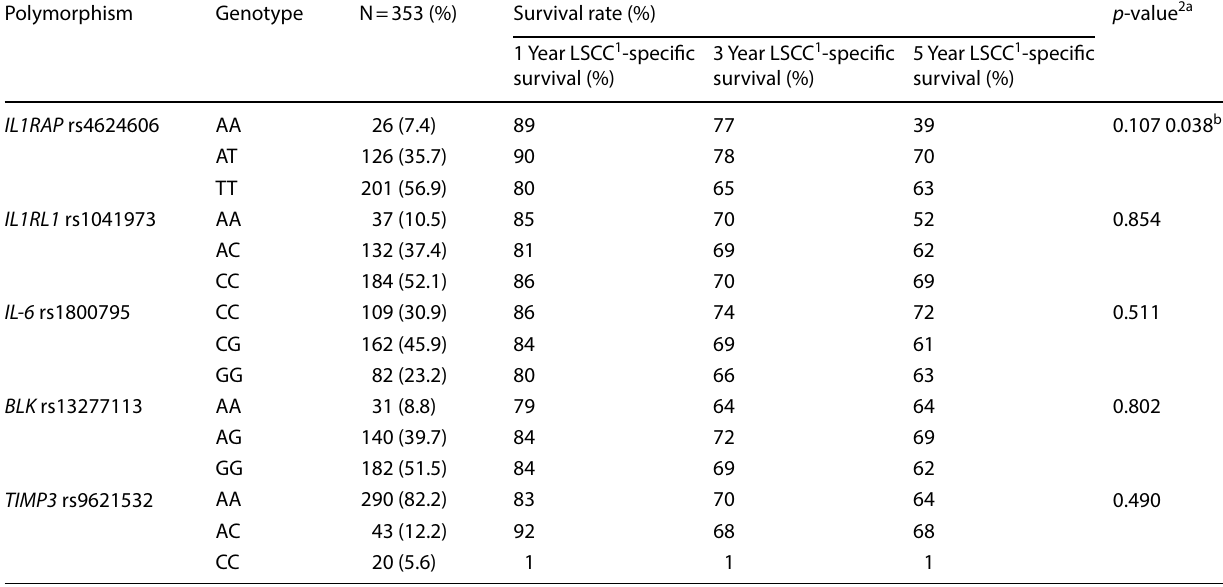
Table3 The genotypic distribution of IL1RAP rs4624606, IL1RL1 rs1041973, IL-6 rs1800795, BLK rs13277113, and TIMP3 rs9621532 SNPs according to the 1-, 3- 5 year survival